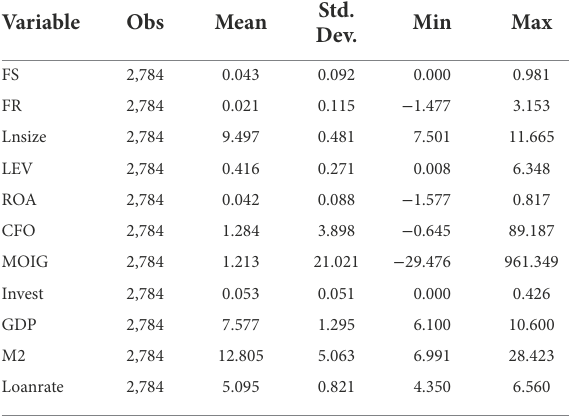
TABLE 2 Descriptive statistics of variables after year-by-year propensity score matching